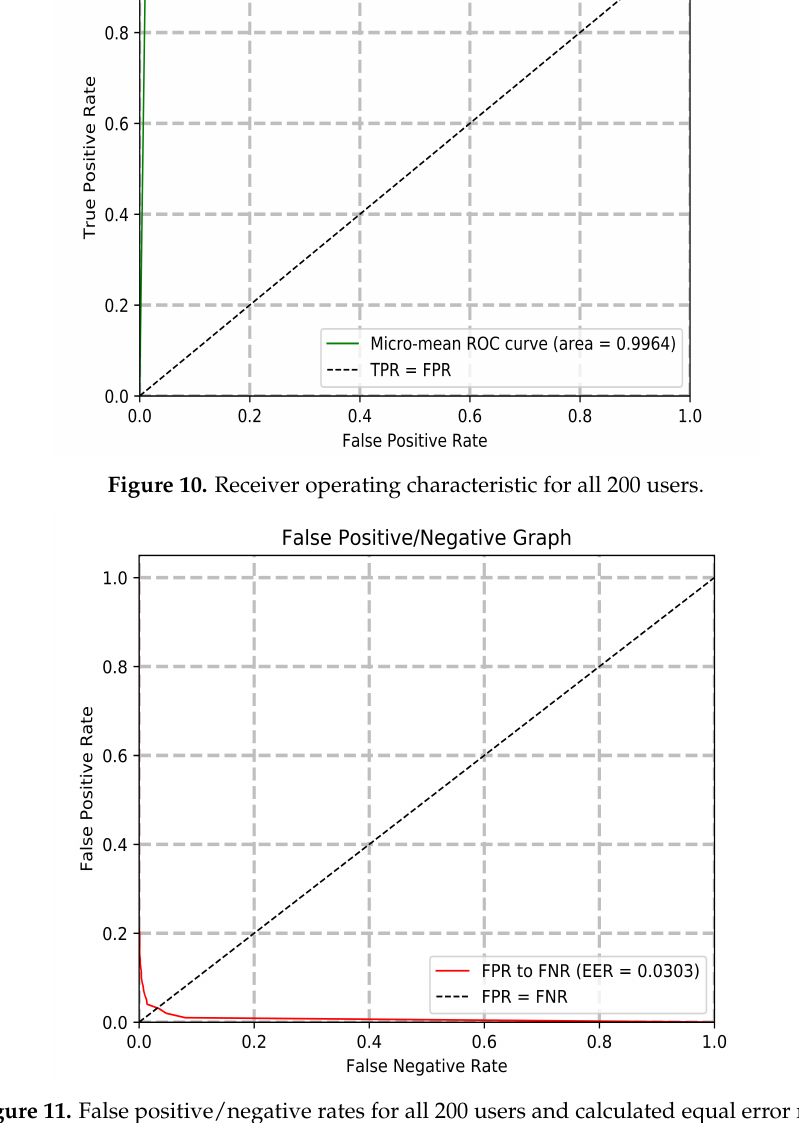
Figure 11. False positive/negative rates for all 200 users and calculated equal error